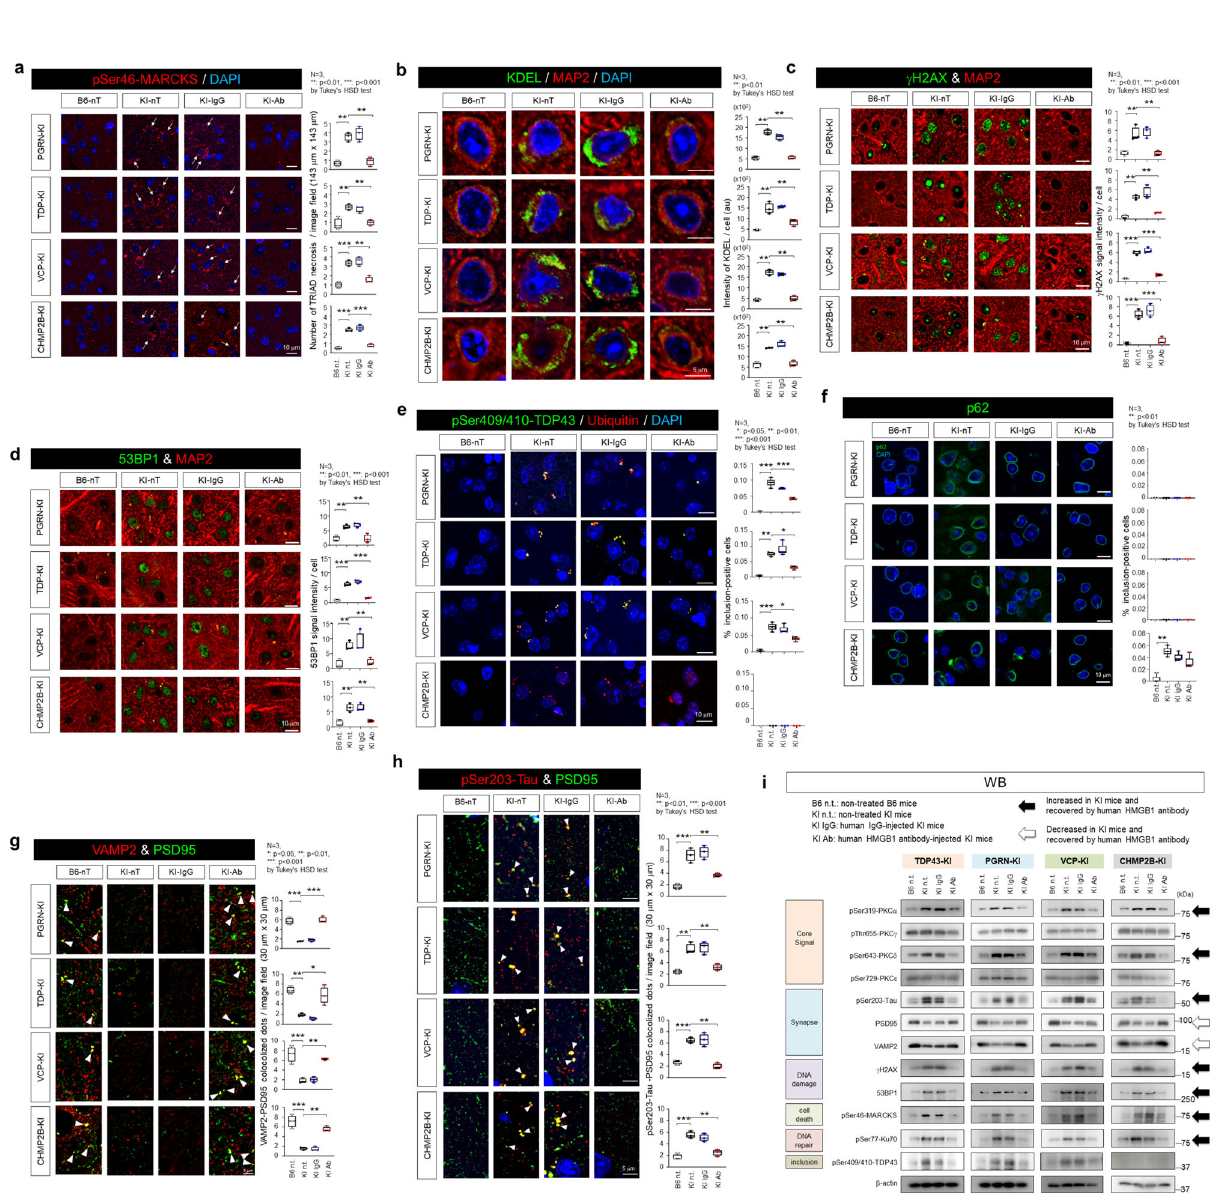
Fig. 4 Therapeutic effects of human anti-HMGB1 monoclonal antibody. Neuronal necrosis, neuronal DNA damage, and inclusion body formation were analyzed by immunohistochemistry. a pSer46-MARCKS for necrosis, b KDEL for necrosis, c γ H2AX for DNA damage, d 53BP1 for DNA damage, e pSer409/410-TDP43 for TDP43-positive inclusion body, f p62 for p62-positive inclusion body, g co-staining of PSD95 and VAMP2 for pre- and post- synapse contact, and h co-staining of PSD95 and pSer203-Tau for synapse abnormality. i Therapeutic effects of human anti-HMGB1 monoclonal antibody assessed by western blot analysis. Box plots show median, quartiles, and whiskers, which represent data outside the 25 – 75th percentile